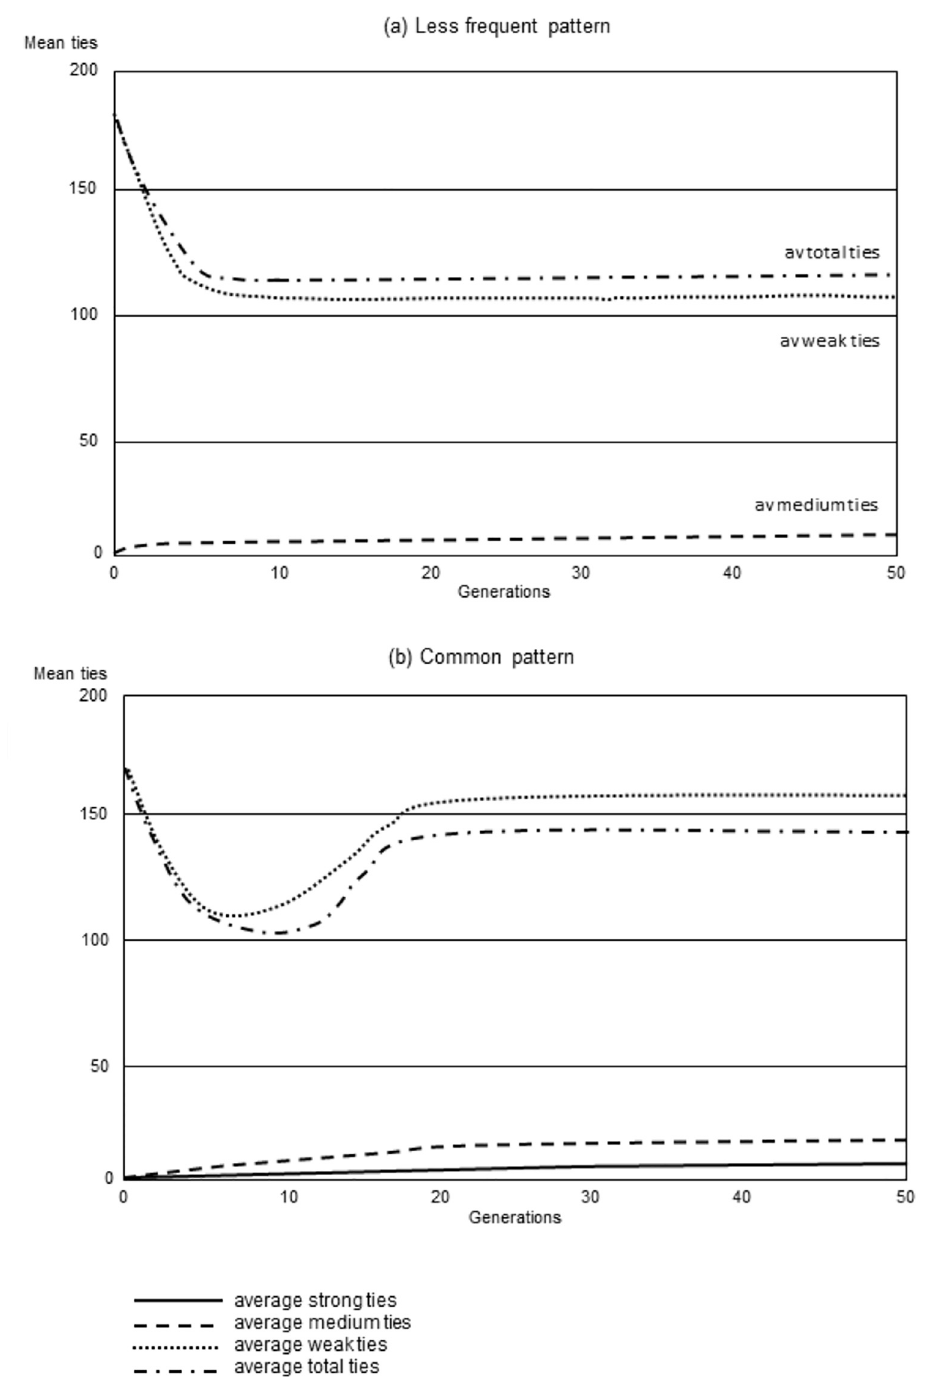
Fig 1. Sample results showing the mean frequency of ties/agent for the whole population over 50 generations for (a) one of the less frequent patterns and (b) the most common pattern. The plotted examples are the outputs at the end (generation 50) of two individual